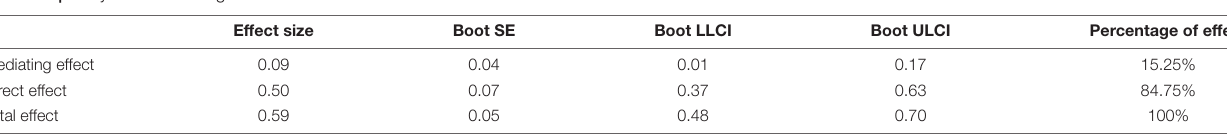
TABLE 4 | Analysis of mediating effect in model